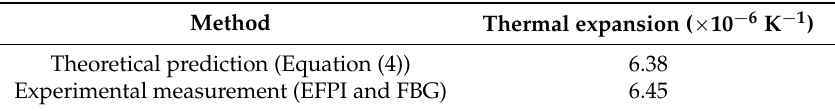
Table 2. A summary of the measured and predicted thermal expansions for the unidirectional 16-ply E-glass/epoxy resin composite.